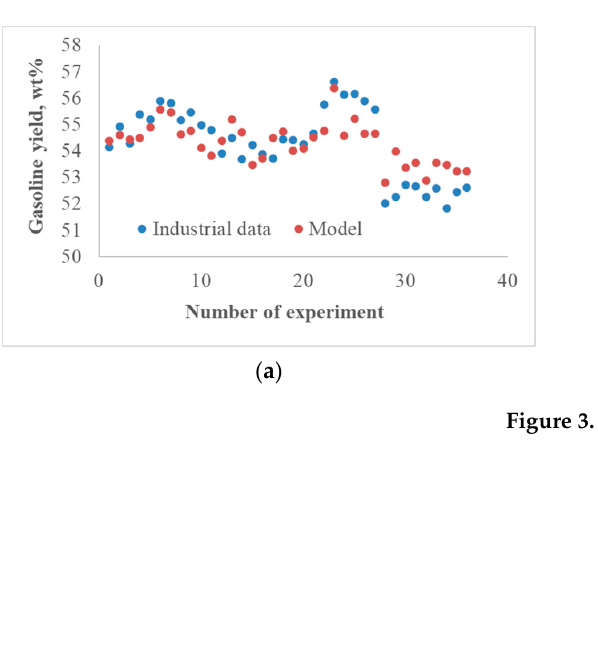
Table 5. Change in the major operating variables for model